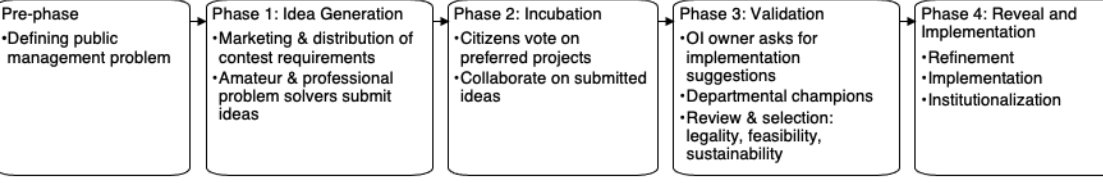
Figure 2. Open innovation phases in the public sector by Mergel [50, Figure I., p. 608], graphically